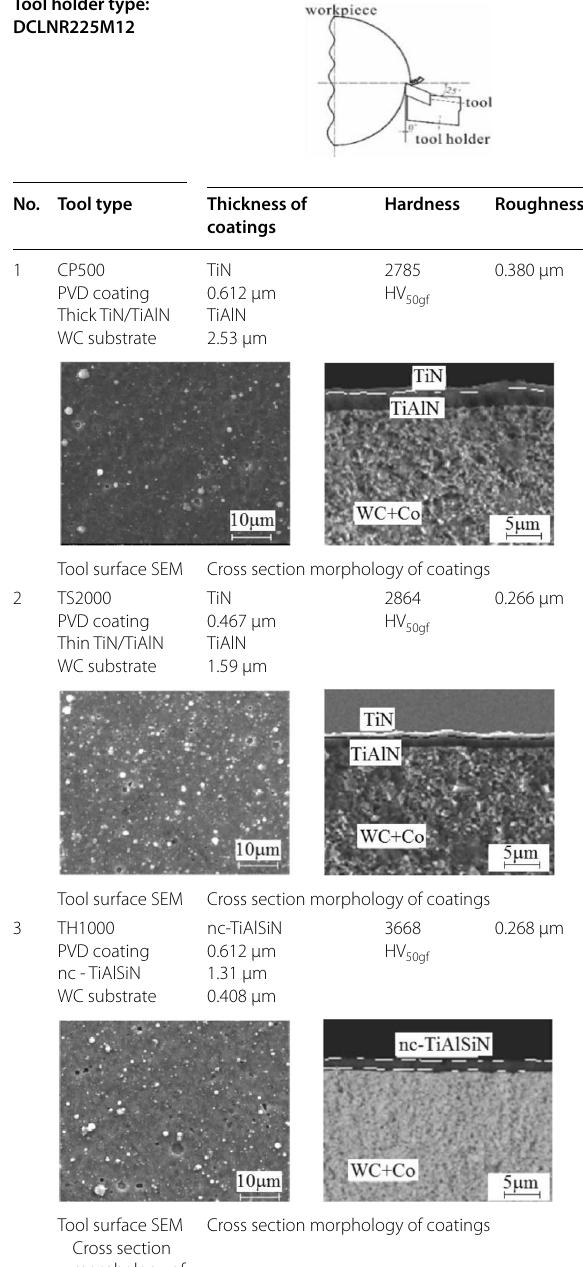
Table 2 Details of the investigated coated tools Tool holder type: